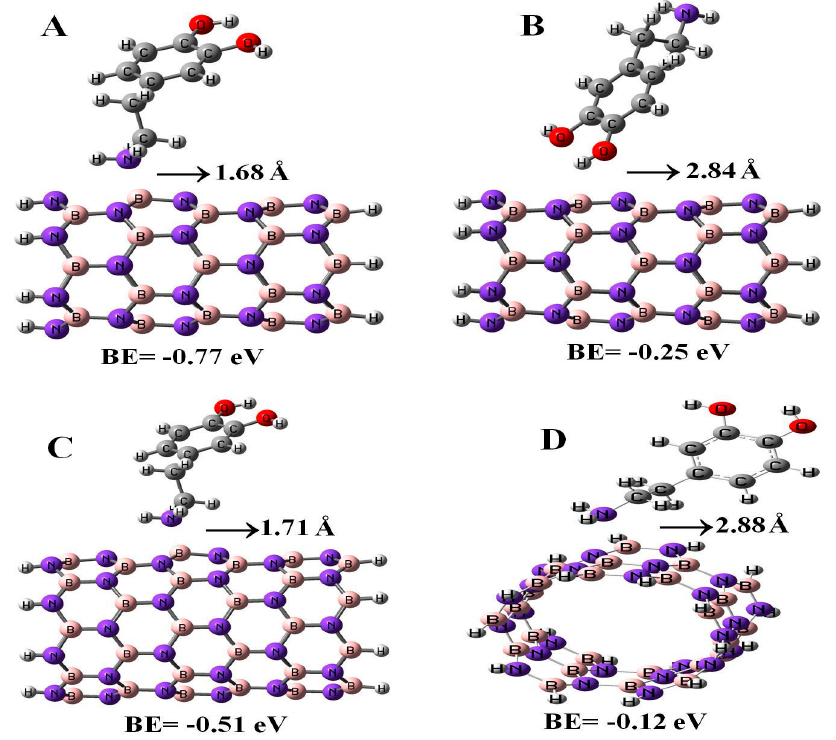
Figure 5. Adsorption of DPM over the (6,0) ( A,B ), (8,0) ( C ), and (5,5) ( D ) BN nanotubes Table 2. Calculated adsorption energy (E ad ), charge (e), HOMO and LUMO energies (E HOMO and E LUMO ), Fermi level energies (E F ), energy gap (E g ), dipole moment (D M ), and quantum